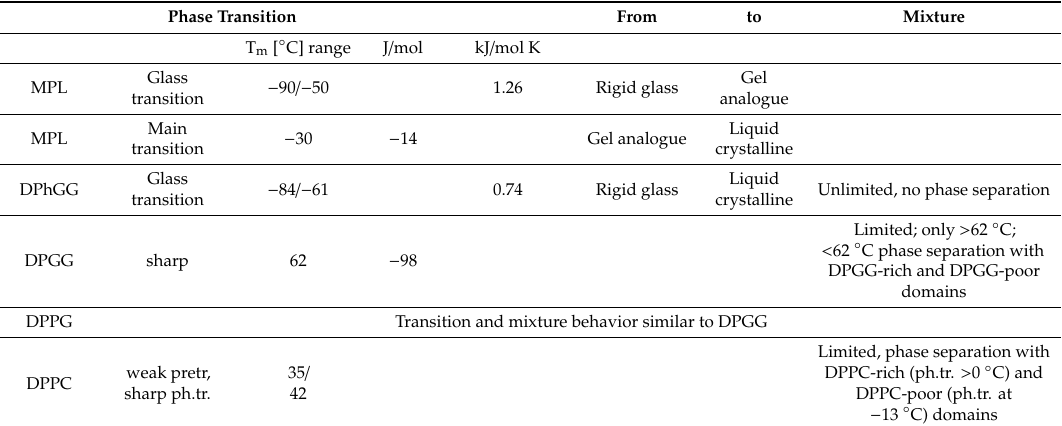
Table 4. Mixture of MPL with other